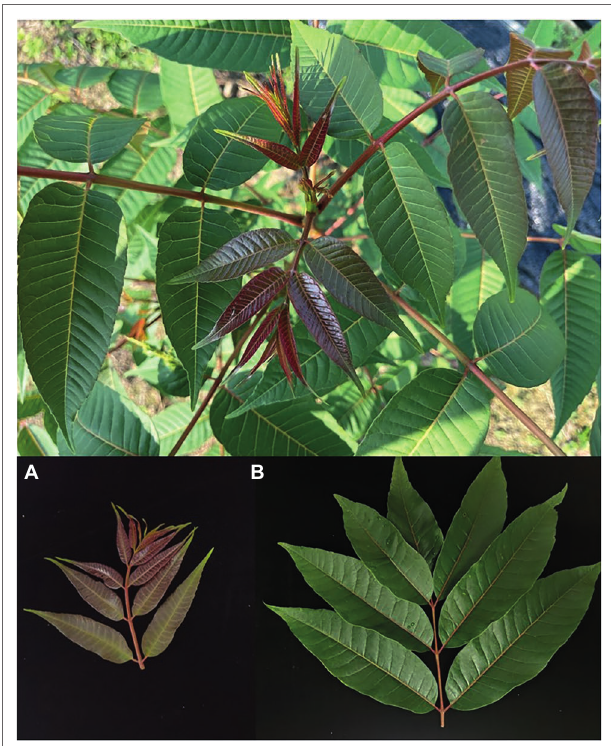
FIGURE 1 | Toona sinensis pictures. (A) The young leaves pictures; (B) The old leaves